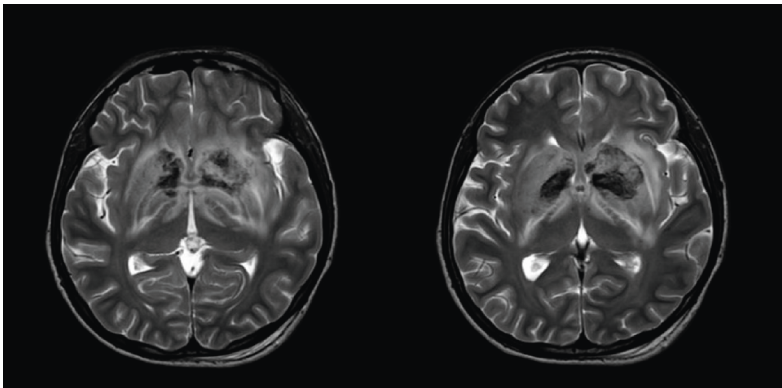
Figure 4: T2-W image, an axial section at basal ganglia.